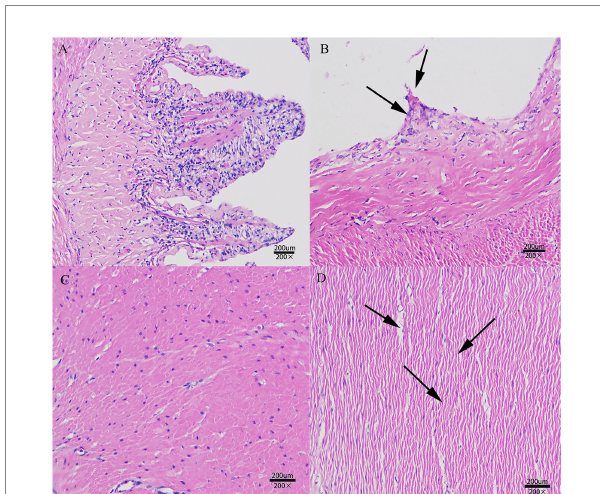
FIGURE 1 Histopathological changes in the intestine of the control and Aeromonas hydrophila groups. (A) The intestinal villi of the control group. (B) The intestinal villi and mesentery in the A. hydrophila group showed serious shedding (thick arrows). (C) The intestinal muscle layer cells of the control group. (D) The intestinal muscle layer cells of the A. hydrophila group. Thick arrows = loose arrangement. Thick arrows = vacuolated